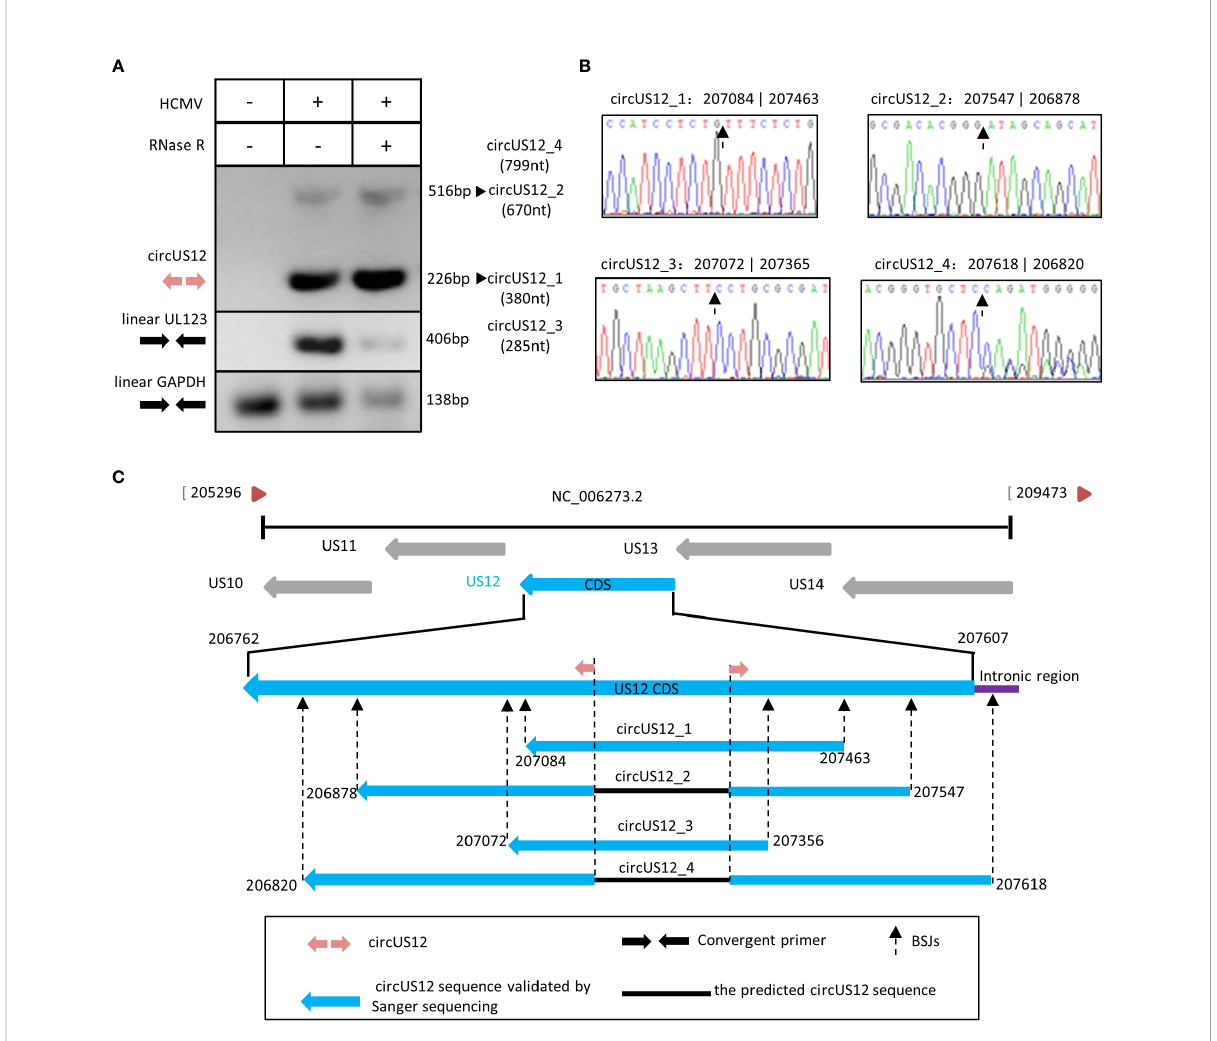
FIGURE 3 Validation and characterization of HCMV circUS12. (A) Inverse RT-PCR products of circUS12 with BSJs validation primer set in Figure 1. The 226 bp band, which was ampli fi ed from circUS12_1 (380 nt), was the predicted amplicon of the primer. Interestingly, the BSJ primer achieved a 516 bp band, which was a part of circUS12_2 (799nt). Linear GAPDH and linear UL123 were ampli fi ed as RNase R-resistant control. (B) Sanger sequencing result of circUS12_1, circUS12_2, circUS12_3, and circUS12_4 BSJs. The BSJ of circUS12_1 was consistent with RNA-seq. The other three circUS12 BSJ that hadn ’ t been demonstrated in RNA-seq, and were revealed in Sanger sequencing. (C) Four circUS12 isoforms mapping to HCMV US12